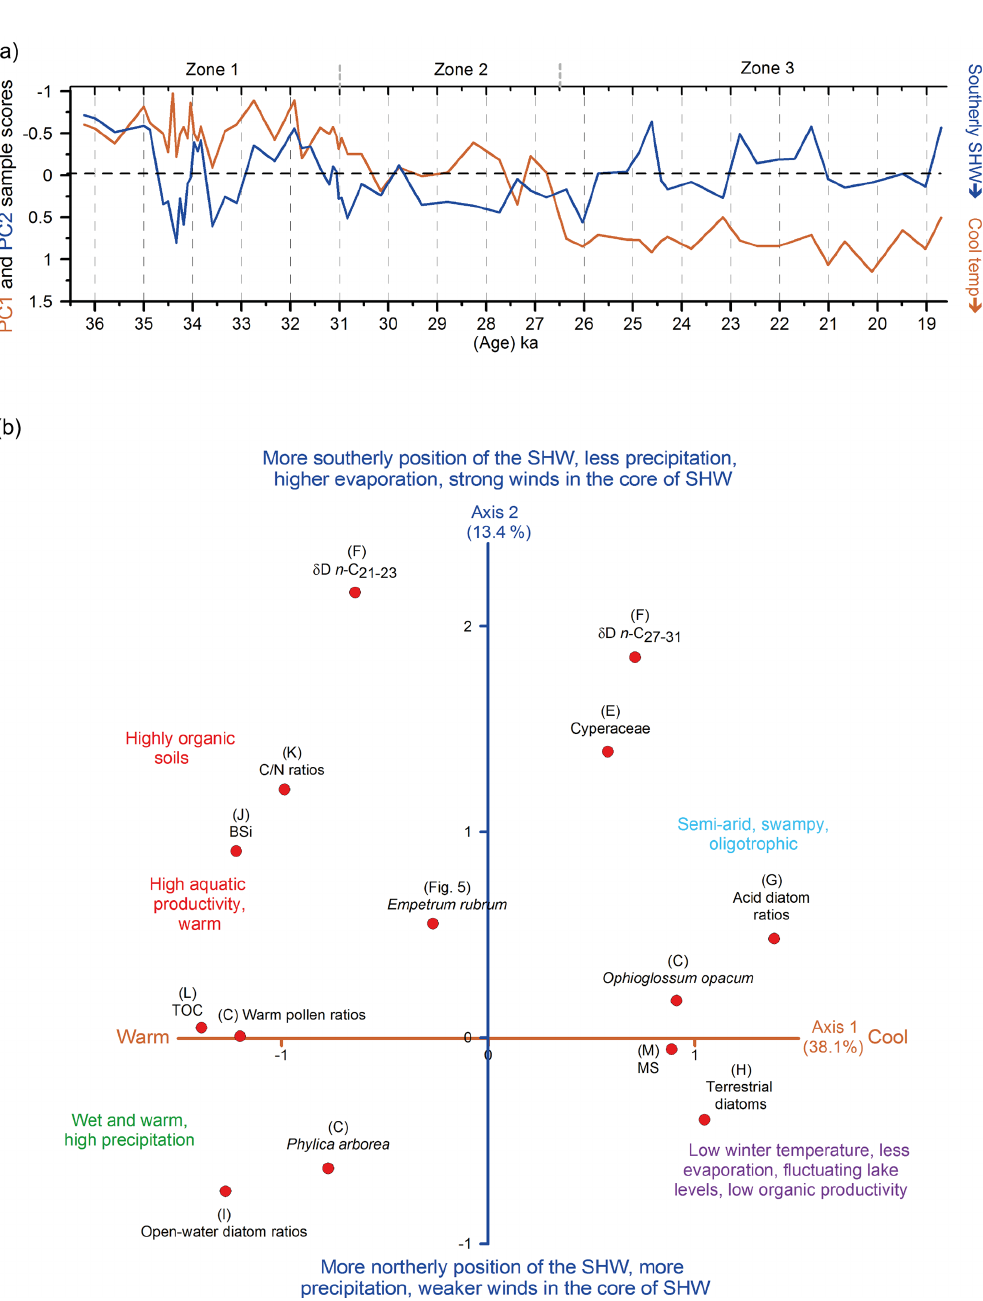
Figure 6. Principal component analysis (PCA) of 14 proxies from 1st Pond. (a) Scores of the first two principal components related to age and the three PCA zones. Note that negative values point upwards and how PC1 and PC2 values are related to temperatures and SHW to the right y axis. (b) PCA plot shows the loadings of the 14 proxies (shown as red dots and black text with reference to proxies in Fig. 4, except for Empetrum rubrum ). PC1 (red-brown) and PC2 (blue) account for 38.1% and 13.4% of the variance, respectively. The interpretations of the two axes are shown by red-brown and blue texts, and the interpretations of the four segments are based on the combined positions of the proxies in the plot (shown in four different